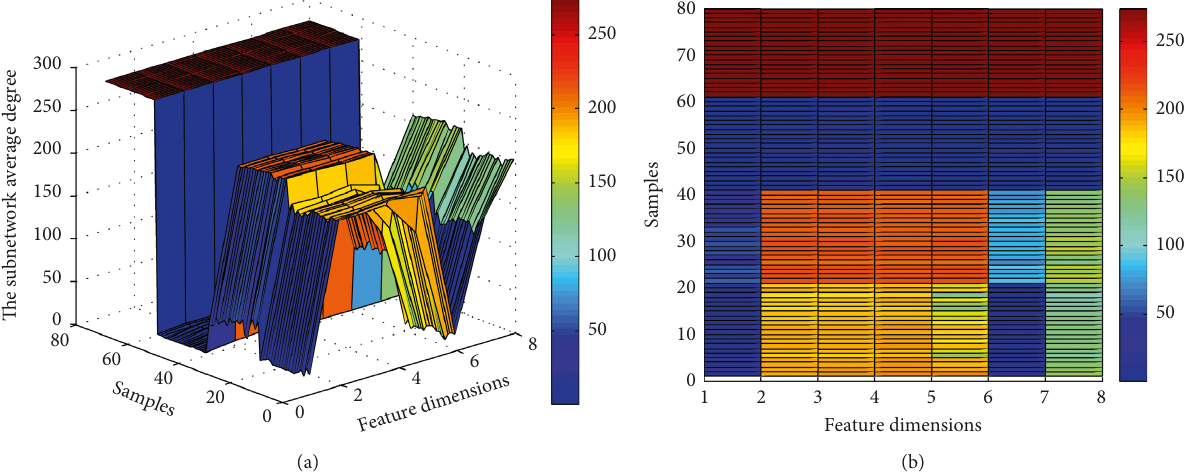
Figure 6: Different fault features’ distribution of rolling bearing. (a) Three-dimensional figure of features’ distribution. (b) Platform of features’